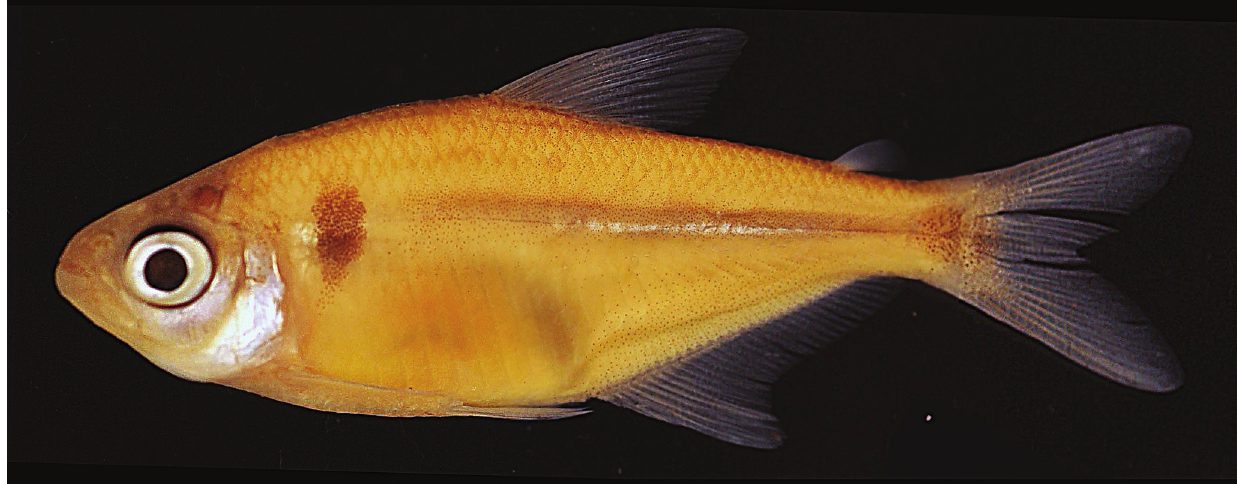
Fig. 5. Probolodus oyakawai , holotype, MZUSP 114013, 40.6 mm SL, Brazil, São Paulo, município de Iporanga, rio Ribeira de Iguape